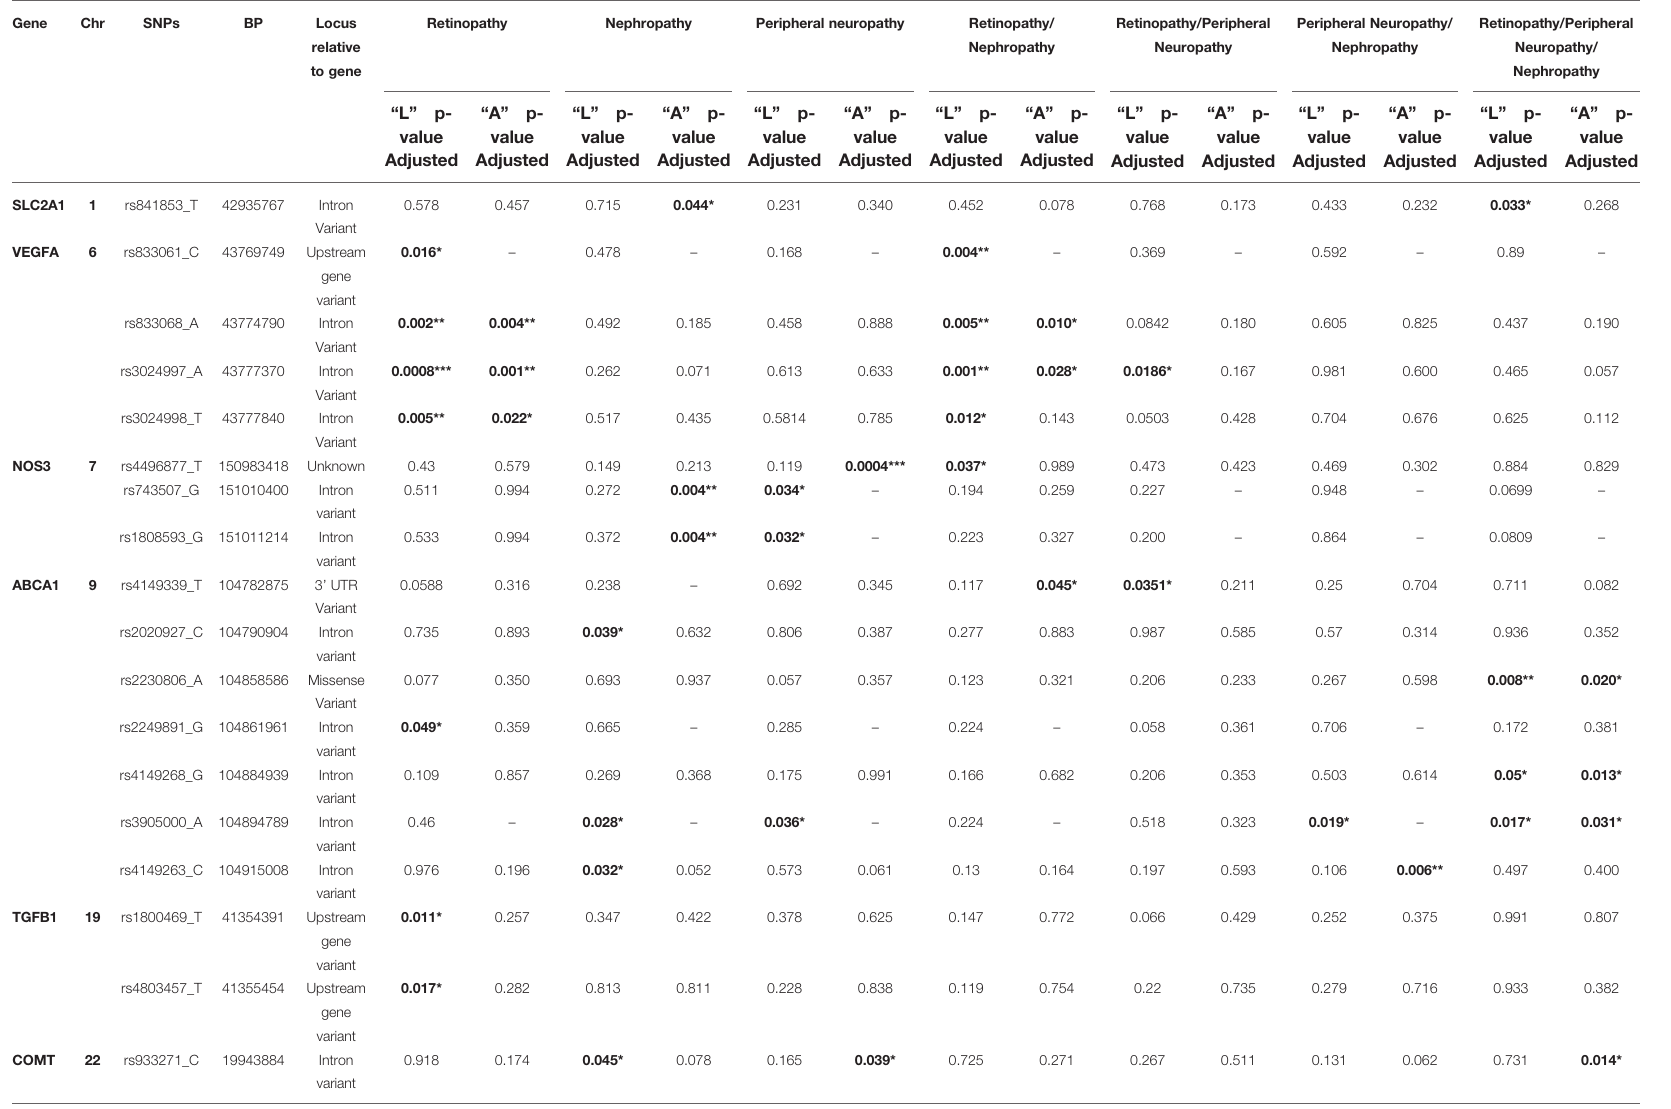
TABLE 2 | Signi fi cant genetic SNP associations to the various complications in the T2DM patient group.